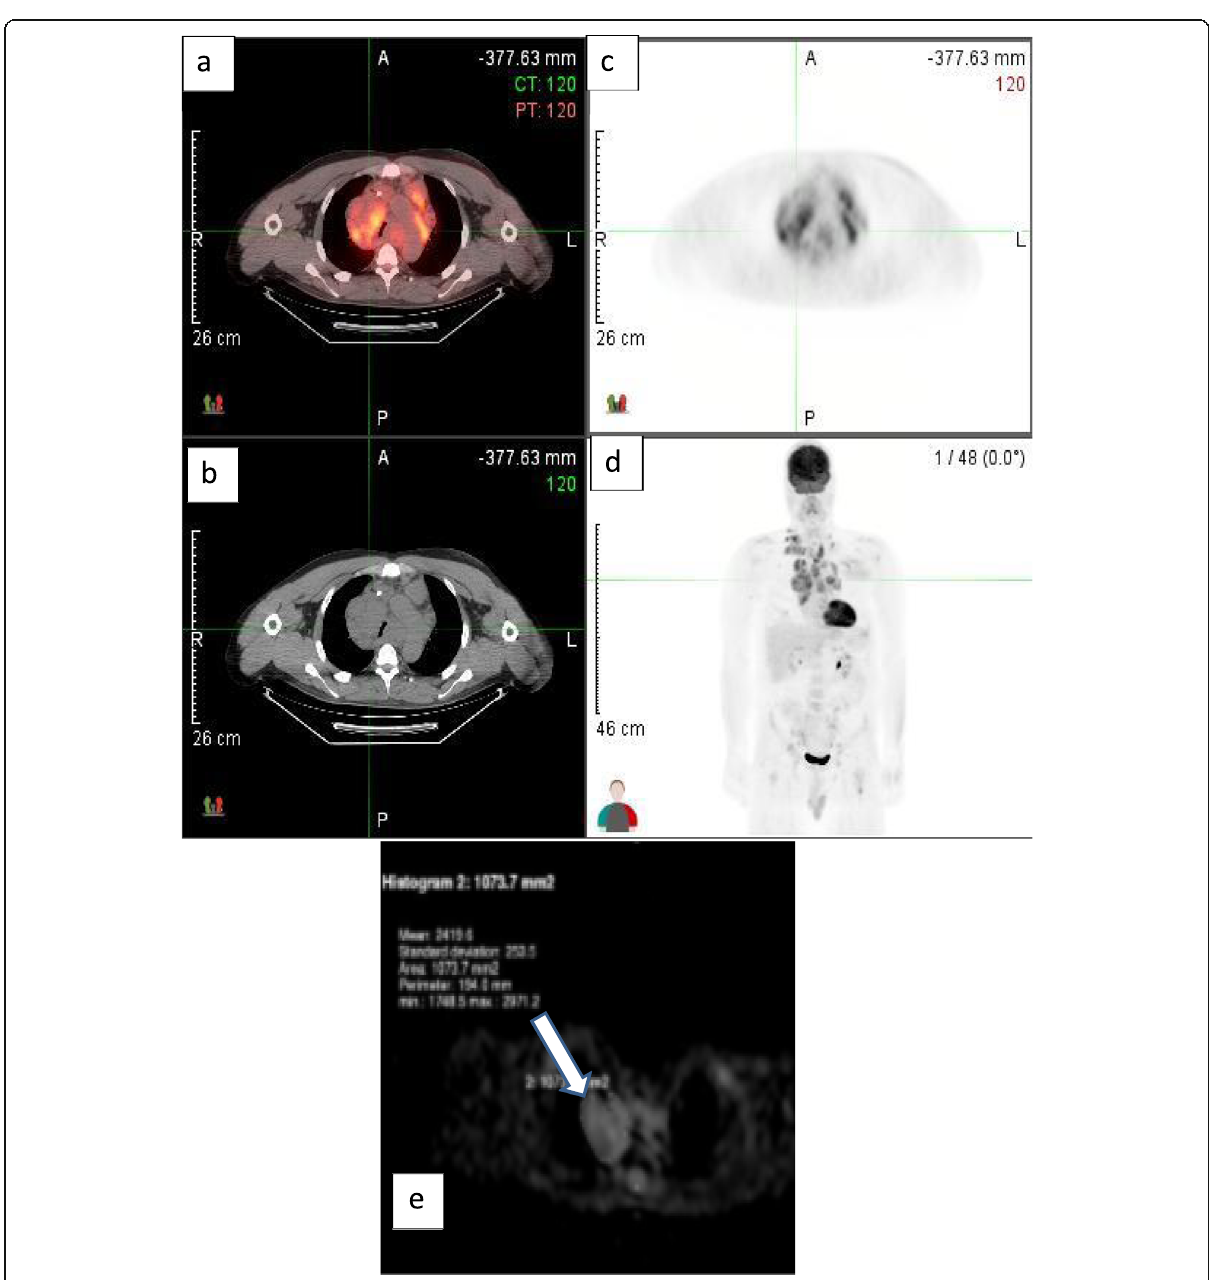
Fig. 2 A 35-year-old male with histopathologically proven lymphoma. Axial PET/CT fused image ( a ), axial CT ( b ), and axial PET ( c ) of the mediastinum,